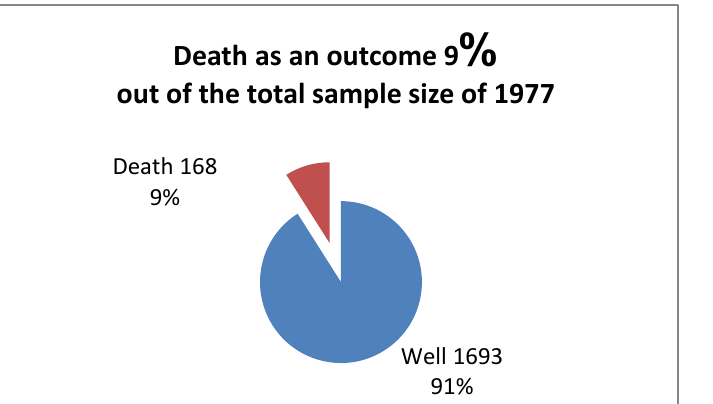
Table 3: The case fatality rate in the total sample